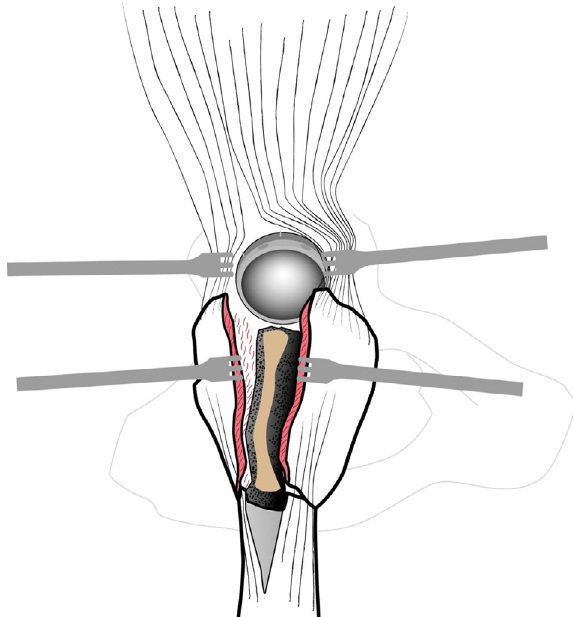
Figure 7. DMC Quattro TM metallic shell.